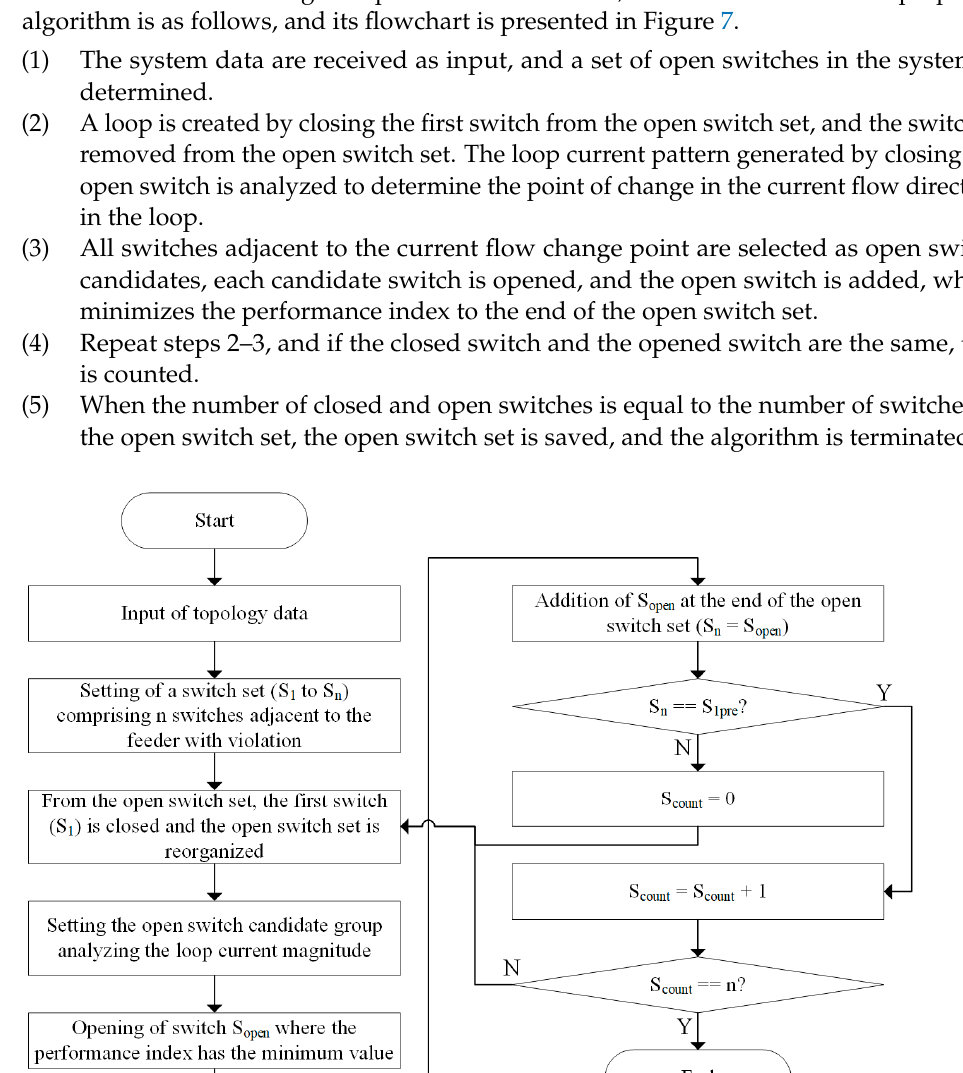
Figure 8. Conceptual diagram of determining the maximum power output limit. The following method determines the maximum output limit of each DG to prevent overcurrent in the system with multiple DGs. a) Method of determining the representative section. The current magnitude of all line sections should be analyzed to designate the allow- able output range of DGs. However, in a radial distribution system with only loads and DGs, the maximum output of each DG can be determined by the current analysis of spe- cific sections. The overcurrent caused by DGs occurs when more current is generated than can be consumed by the load. Therefore, the overcurrent flows in the reverse direction toward the feeder terminal. Among the possible current combinations of each DG, the